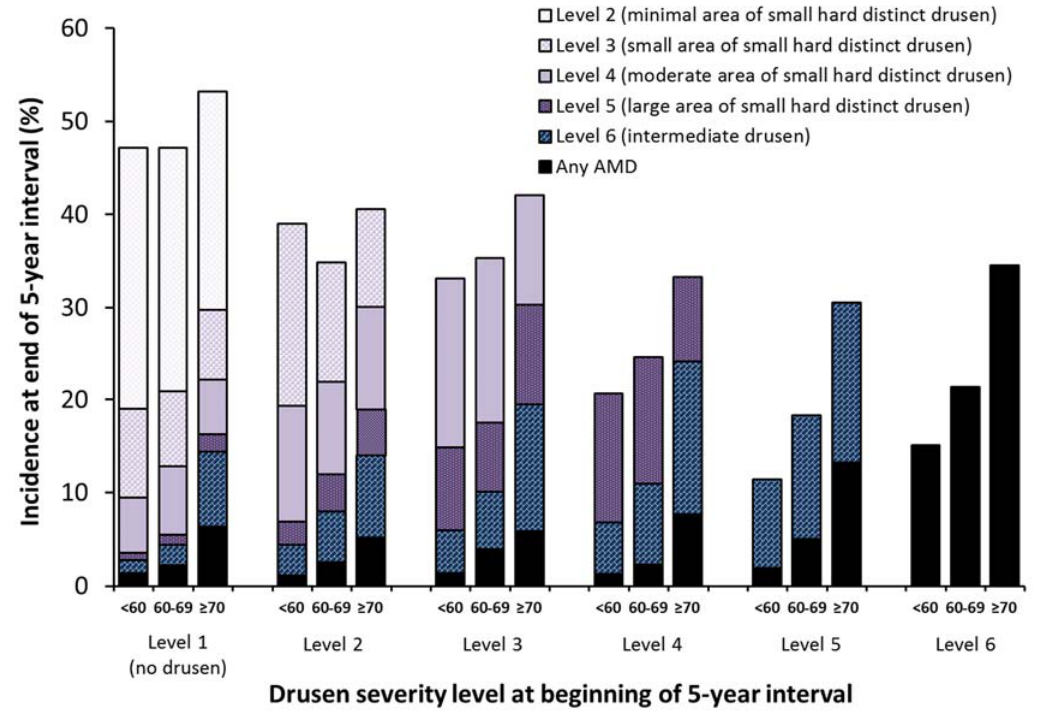
Figure 2. Five-year incidence of increasing area of small hard drusen, intermediate drusen, and any AMD by age group (<60, 60–69, and ≥ 70 years) and severity level at the beginning of the